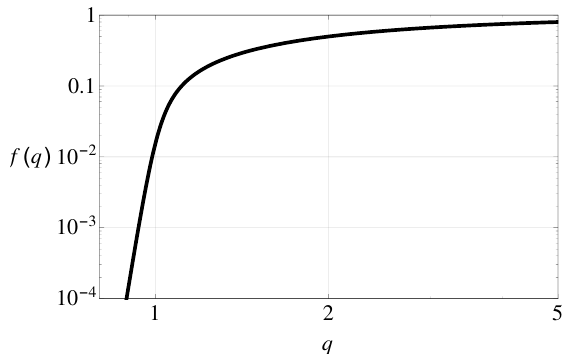
Figure 6 . The dependence of the axion number density, relative to its value in the limit q ! 1 , f ( q ) (cid:17) n a = (8 H(cid:24)(cid:22) e(cid:11) =x 0 ) on the power q of the spectrum of axions emitted by the string network, at the physically relevant scale separation log ( m r =H ) (cid:25)